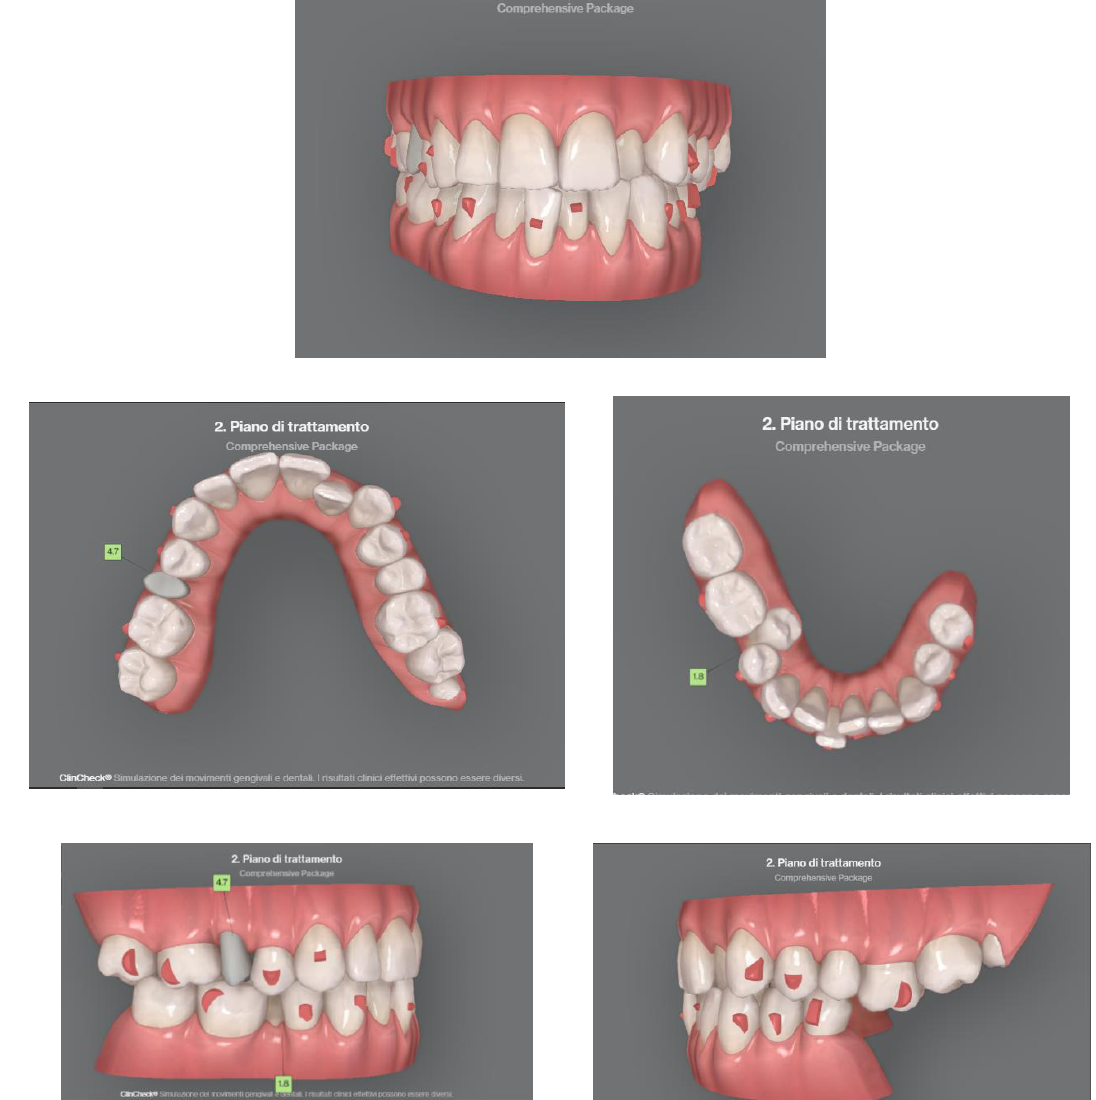
Figure 10. Clinical case treated with Invisalign © aligners. Intraoral views from ClinCheck. Frontal, upper, and lower occlusal and lateral view of occlusion before the beginning of treatment.